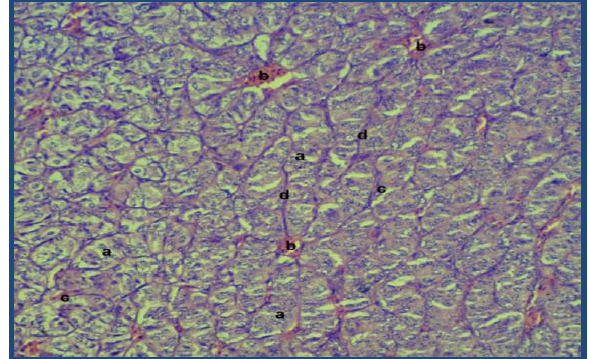
Figure, 9: Parathyroid parenchyma composed of: a- Cords of chief cells b- Sinusoids c- Thin septa d- Connective tissue sheath (PAS stain, 20 X).